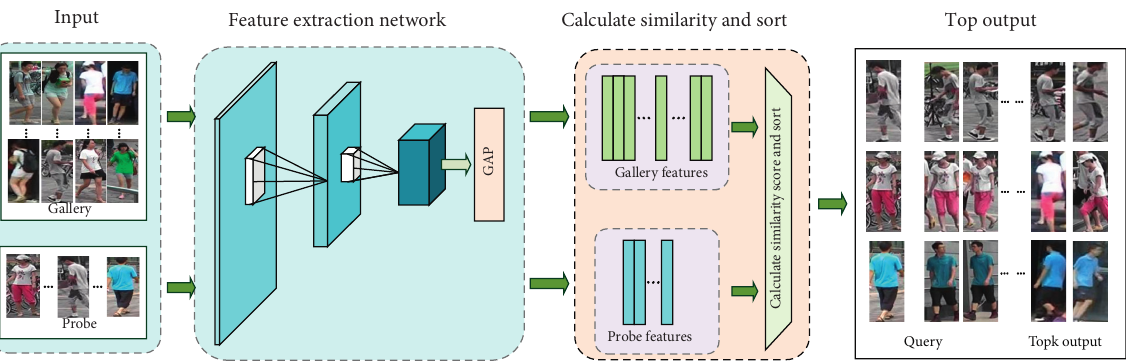
Figure 1: The overall framework of the algorithm model.